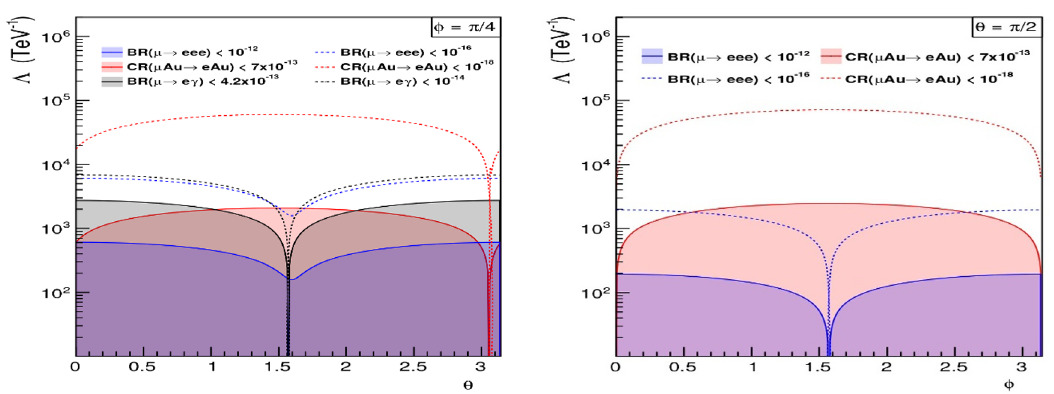
Figure 2 . The bound on Λ NP from current constraints on µ → e L γ (black; vanishes at θ = π/ 2 ), µ → e L e L e L (blue; dips at θ, φ ∼ π/ 2 ) and µA → e L A (red; vanishes at θ, φ ∼ π ), as a function of coefficients at m W . Dotted lines indicate possible bounds from future experimental sensitivities. The operator coefficients are parametrised in spherical coordinates in the subspace probed by the experimental processes: the vertical axis is the direction probed by µ → e L γ (see eq. (2.17)) and the xy plane is spanned by ~u µ Au → e ( m W ) and ~u µ ( m W ) , see eq. (3.5). The first plot is L Au L → e L e L e L for φ = π/ 4 , and the second for θ = π/ 2 (where the dipole vanishes). See discussion at the end of section